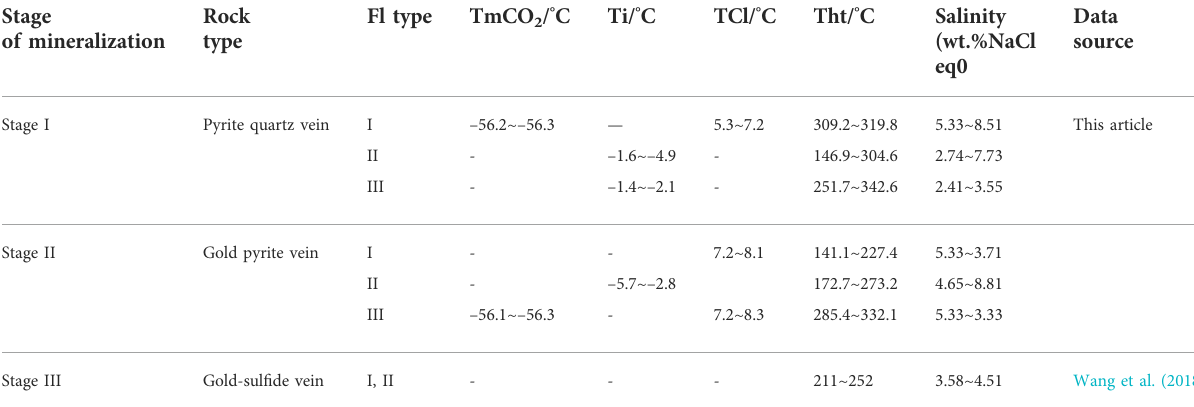
TABLE 1 Microthermometric measurements of fl uid inclusions of different mineralization stages in the Houge ’ zhuang gold deposit. Stage of